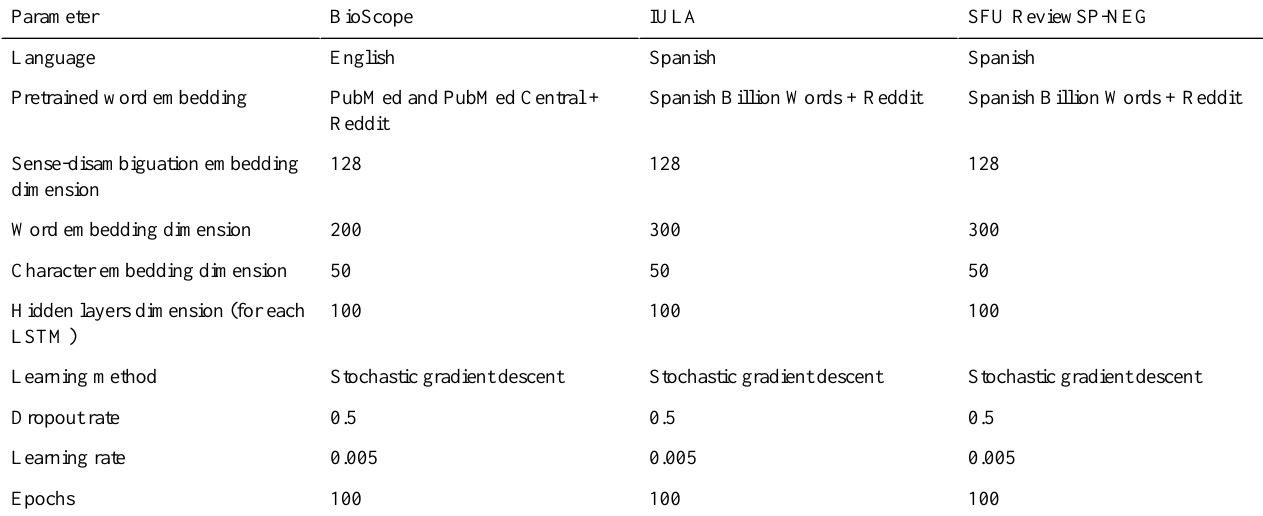
Table 15. NeuroNER system hyperparameters for each task.